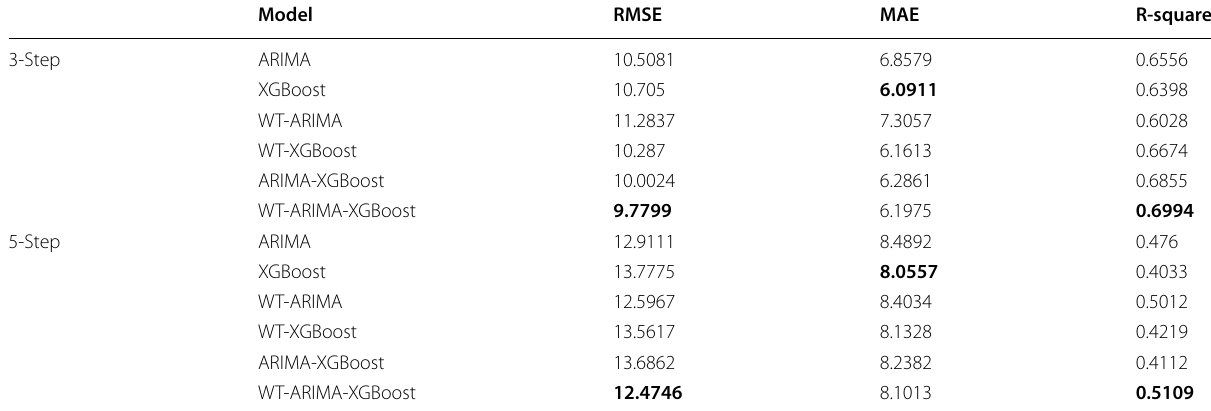
Table 3 Evaluation indicator values for layer actions response time under different time granularities